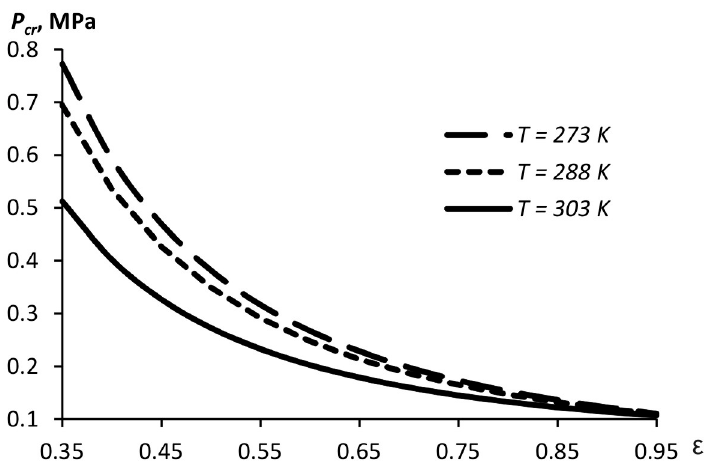
Figure 4. Critical cavitation pressure in the pulse atomizer design as a function of the compression ratio and temperature for aqueous solutions.